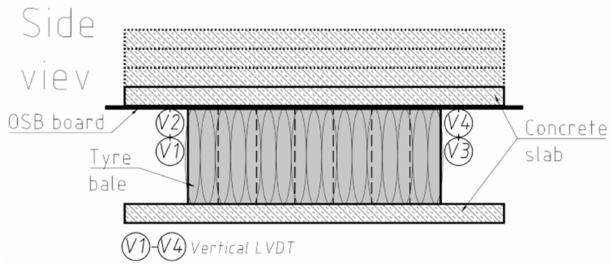
Figure 9. Creep test